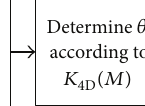
Received signals